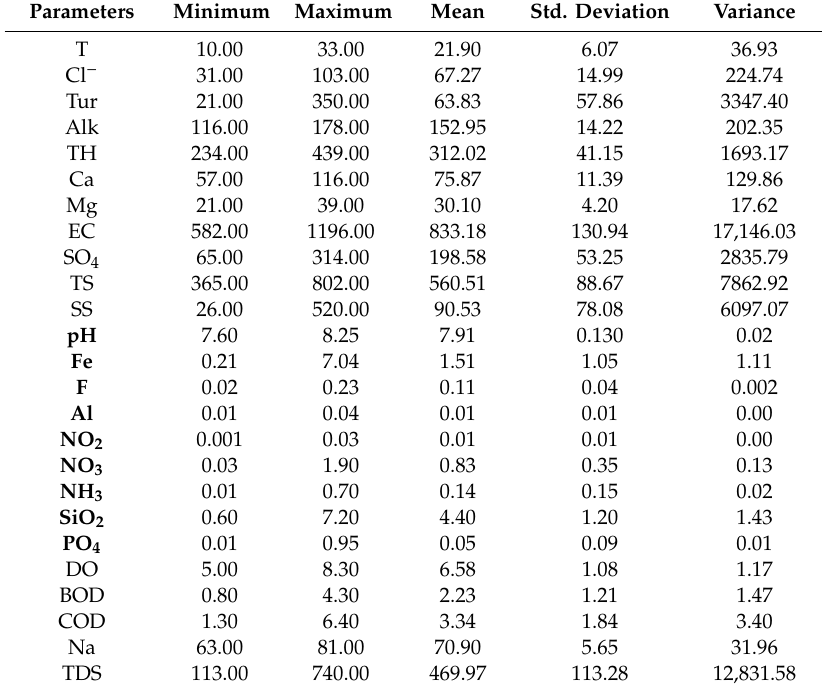
Table 1. Some descriptive statistics of the 25 water quality parameters included in this study, all in mg / L, except the T in ( ◦ C), Tur in (NTU), EC in ( µ S / cm − 1 ), and pH. The nine parameters in bold have the little mean and variance